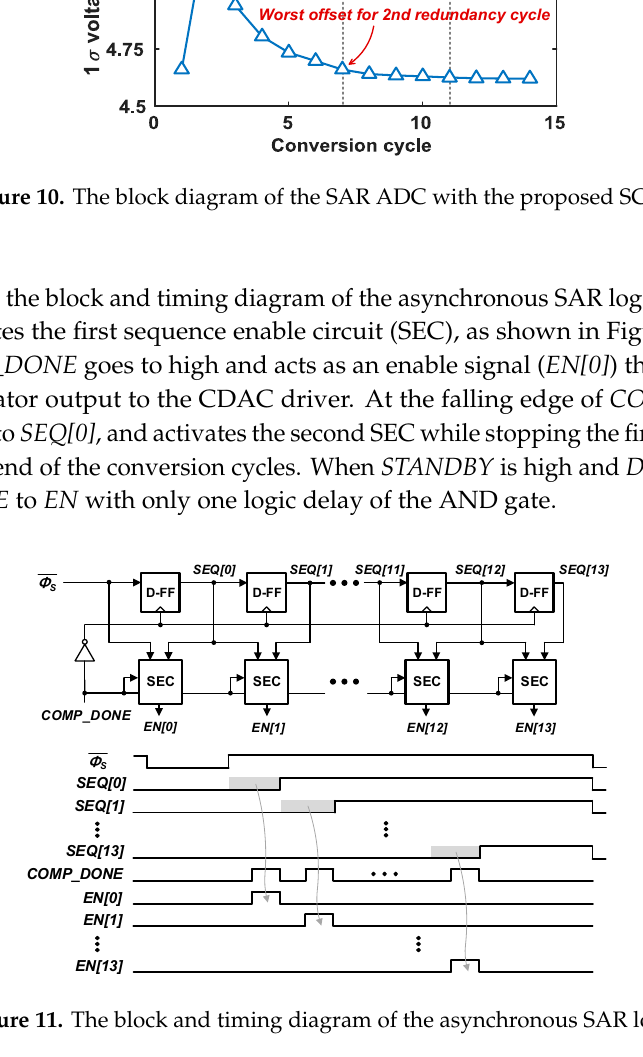
Figure 12. The schematic of the sequence enable circuit (SEC) and latch. 3.3. Layout of the CDAC and CRD Figure 13 shows the layout of the CDAC. The unit capacitance of the CDAC is 0.4 fF, which leads to a total capacitance of about 850 fF, including two redundancy capacitors (25.6 Ff + 3.2 fF). The CDAC consists of a custom metal-oxide–metal (MOM) capacitor with an upper metal layer to minimize the parasitic capacitance from the substrate. The CRD is located under the CDAC to eliminate the additional chip area, and is implemented with MOS capacitors to maximize 𝐶 (cid:3019)(cid:3006)(cid:3007) for the given area. The total capacitance of the CRD is 110 pF, which is about 2 7 times larger than 𝐶 (cid:3005)(cid:3002)(cid:3004) . Figure 13. The layout of the CDAC with the CRD using MOS capacitors.